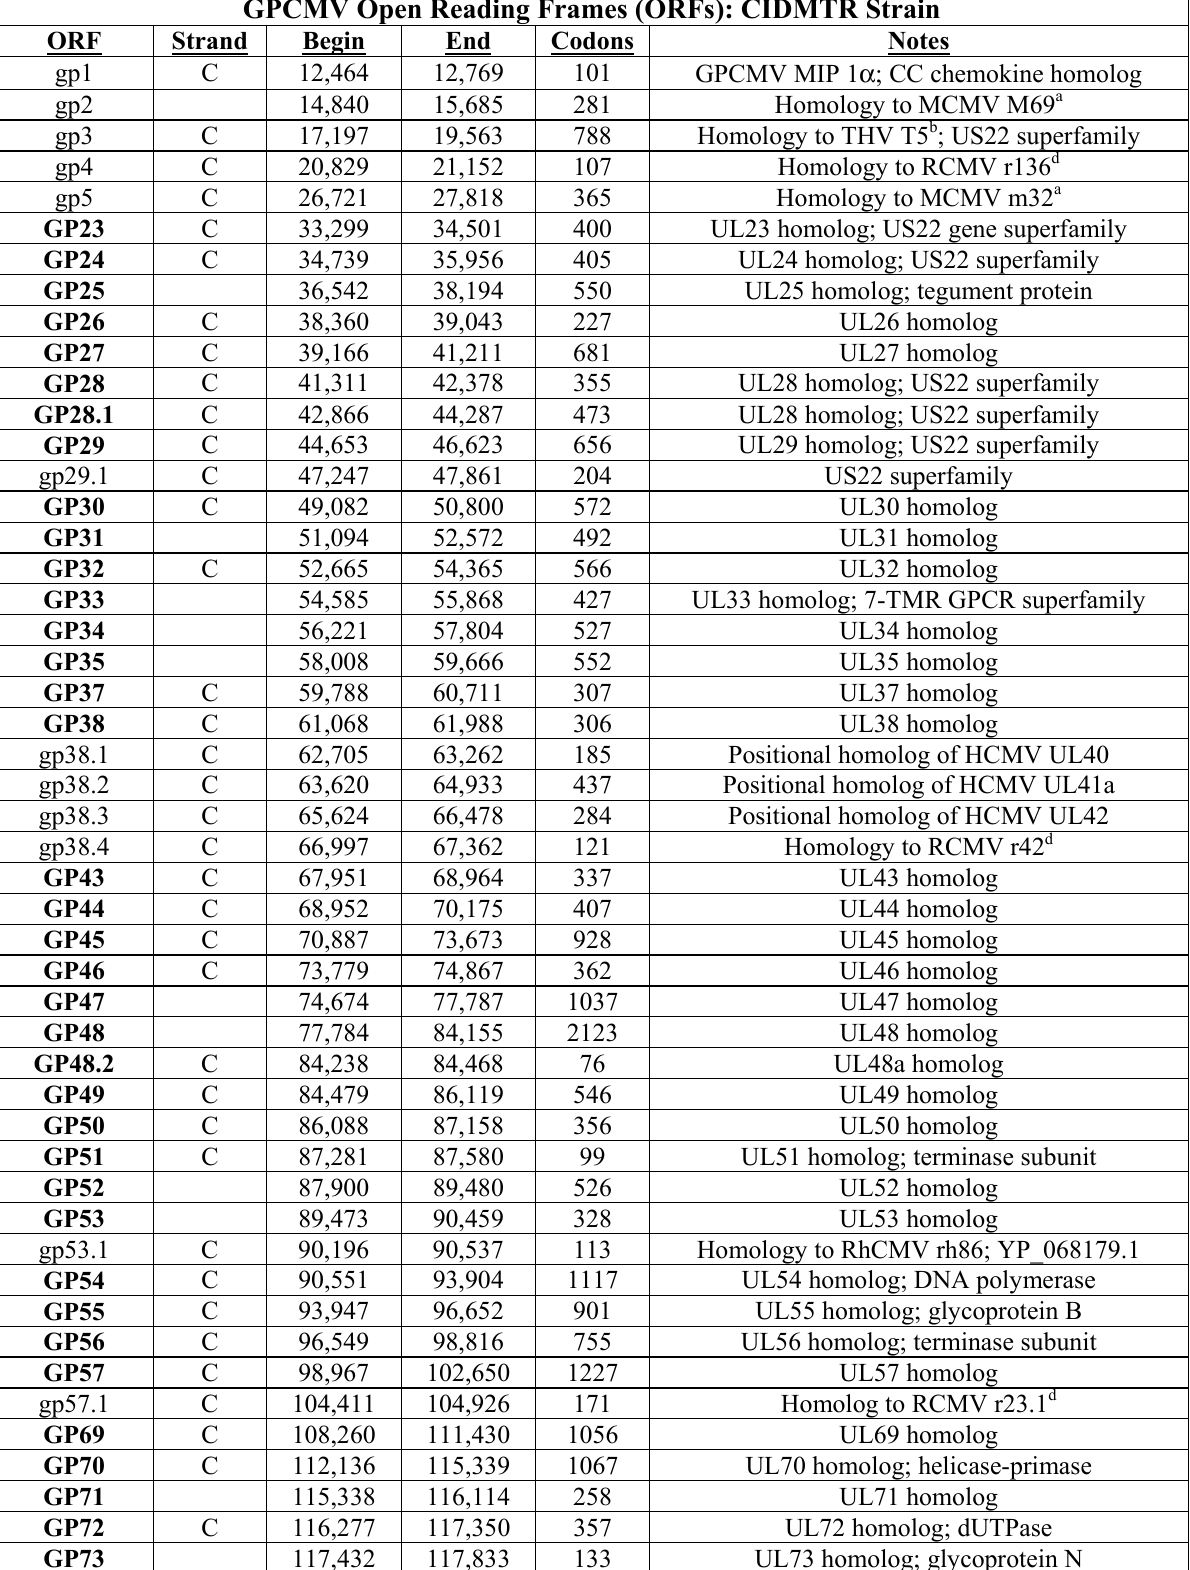
Table 1. GPCMV Strain CIDMTR Predicted ORFs. GPCMV Open Reading Frames (ORFs): CIDMTR